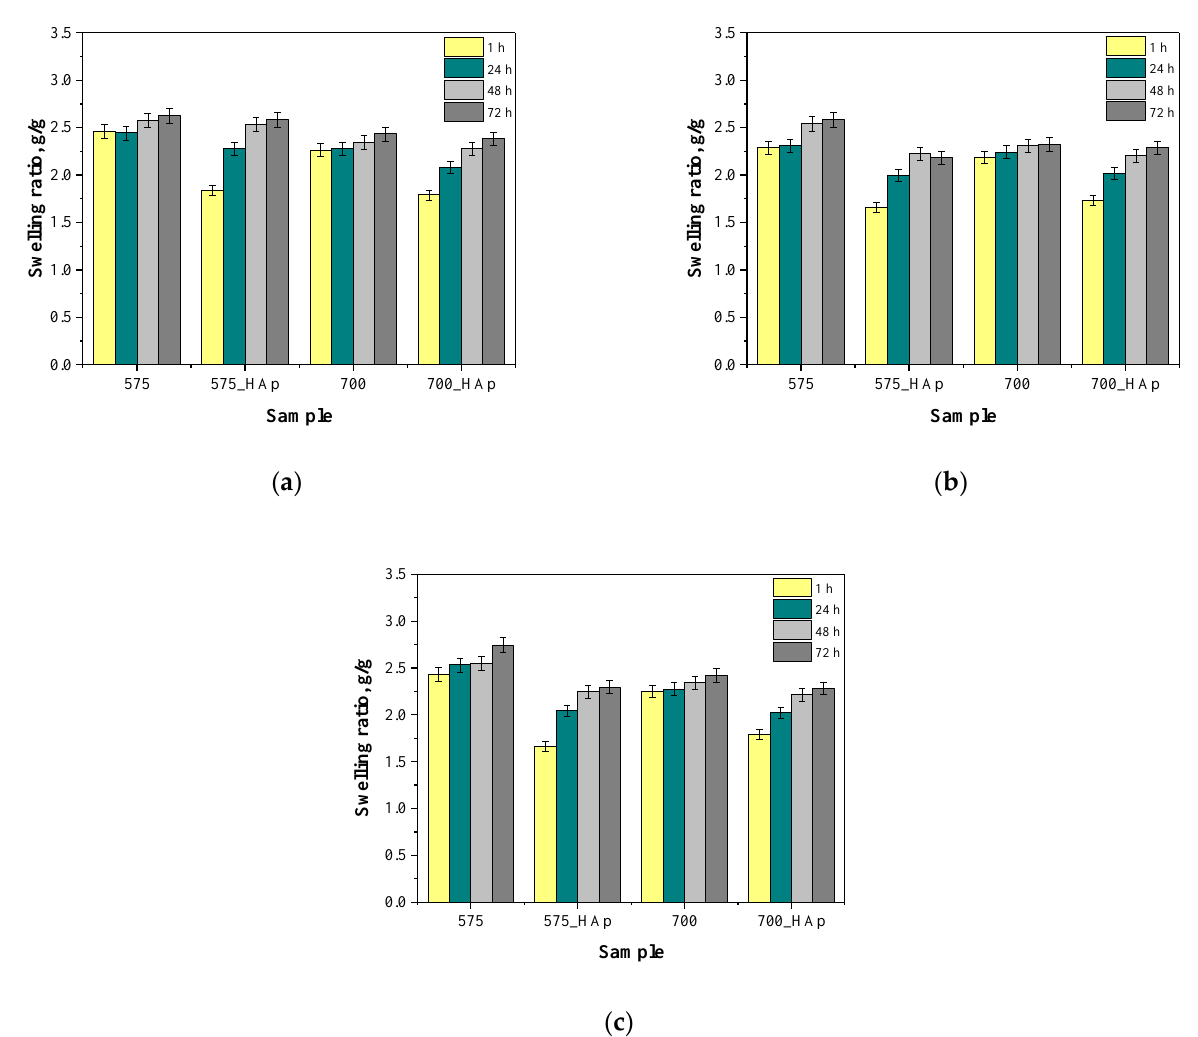
Figure 9. Results of sorption analysis in distilled water ( a ), SBF ( b ) and Ringer liquid ( c ).